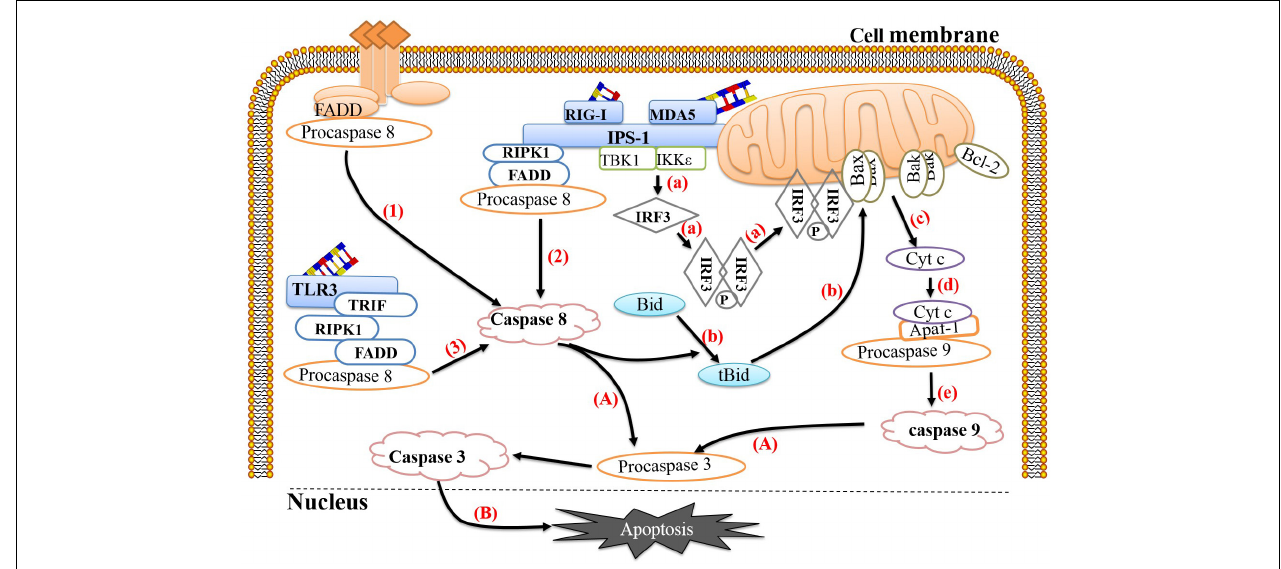
FIGURE 1 | Link between pathogen recognition and apoptosis. (1) The death ligands TNF and FasL bind to their corresponding receptors, TNFR and Fas, and recruit TRADD and FADD, respectively, which then bind to procaspase 8 to form the death-inducing signaling complex (DISC) to activate caspase 8. (2) RIG-1 or MDA-5 recognizes viral dsRNA and recruits IPS-1. Activated IPS-1 recruits FADD and RIPK1 to form a complex and then recruits and activates procaspase 8. (3) TLR-3 recognizes viral dsRNA in the cytoplasm and exposes the TIR domain. The adaptor TRIF containing the TIR domain binds to RIPK. The C-terminus of RIPK1 has a death domain (DD), which can interact with FADD, after which FADD recruits and activates procaspase 8. (a) Activated IPS-1 can also recruit IKK ε and TBK1, causing phosphorylation and dimerization of IRF-3. The IRF-3 homodimer can translocate to the mitochondrial membrane and form a complex with Bax. (b) Activated caspase 8 can cleave Bid to form tBid with proapoptotic activity, which can induce Bax and Bak to insert into the outer mitochondrial membrane. (c) Bax or Bak undergoes conformational changes and forms heterodimers or homodimers, thereby destroying the mitochondrial membrane and reducing the mitochondrial membrane potential. Subsequently, mitochondria release Cyt c into the cytoplasm. (d,e) Cyt c, procaspase 9 and Apaf-1 combine to form a complex that cleaves procaspase 9 into caspase 9. (A) Caspase 9 and caspase 8 cleave procaspase 3 into caspase 3. (B) Caspase 3 translocates to the nucleus and activates proteins, ultimately leading to apoptosis. The image content has been borrowed from other articles in the literature (Croft et al., 2017; Sun et al., 2019).